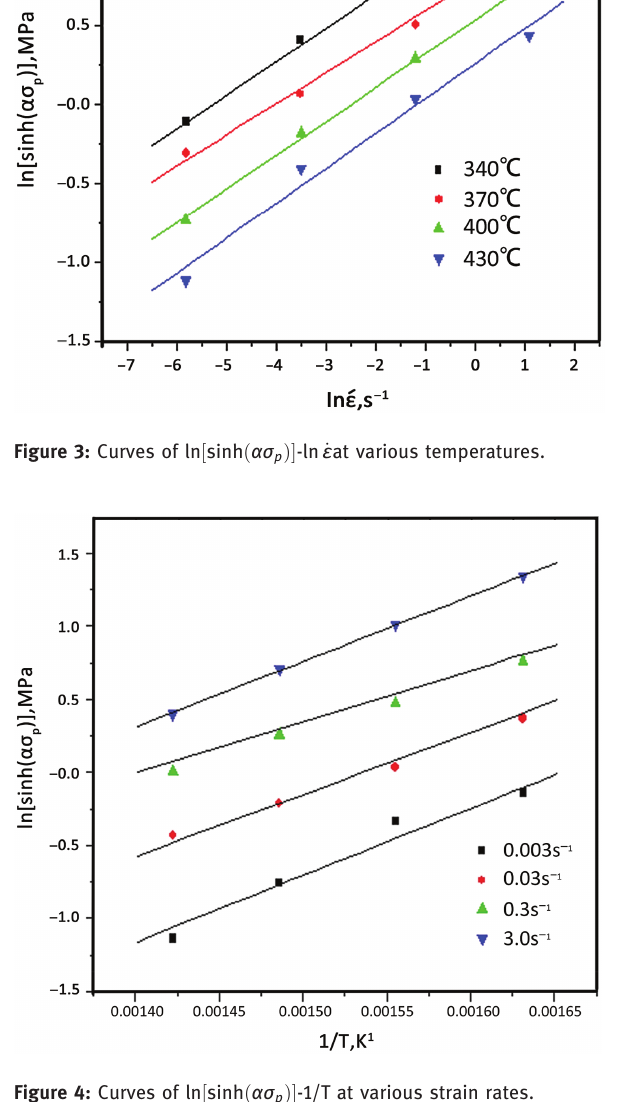
Figure 4: Curves of ln ½ sinh ð ασ p Þ(cid:2) -1/T at various strain rates.